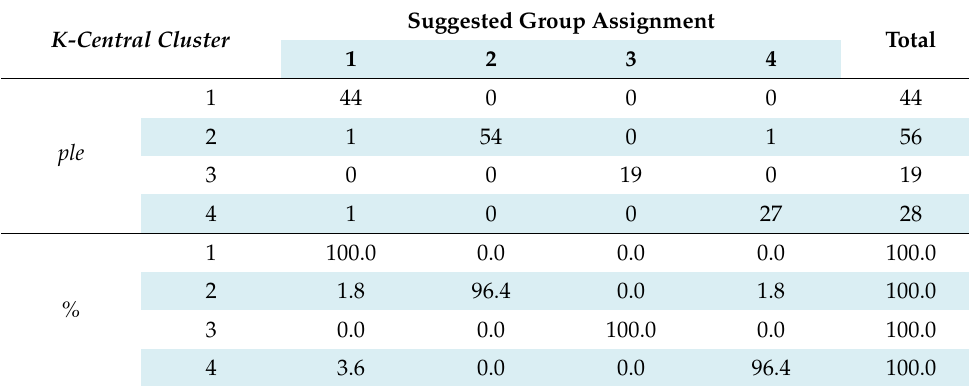
Table 4. Discriminant analysis for defined